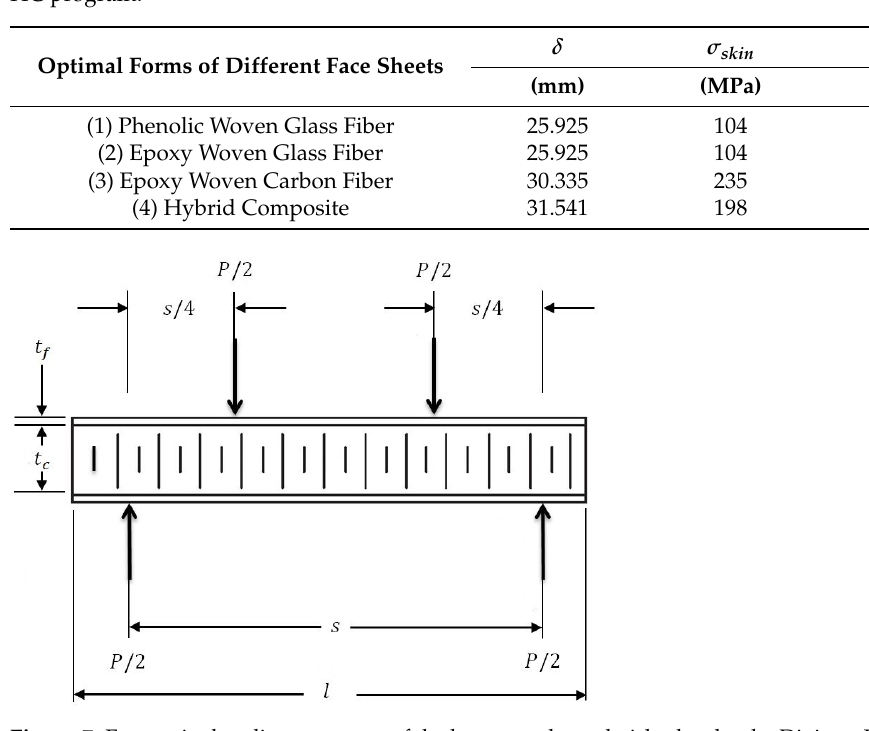
Table 10. Numerical results of honeycomb sandwich models of helicopter floor using the Digimat- HC program.